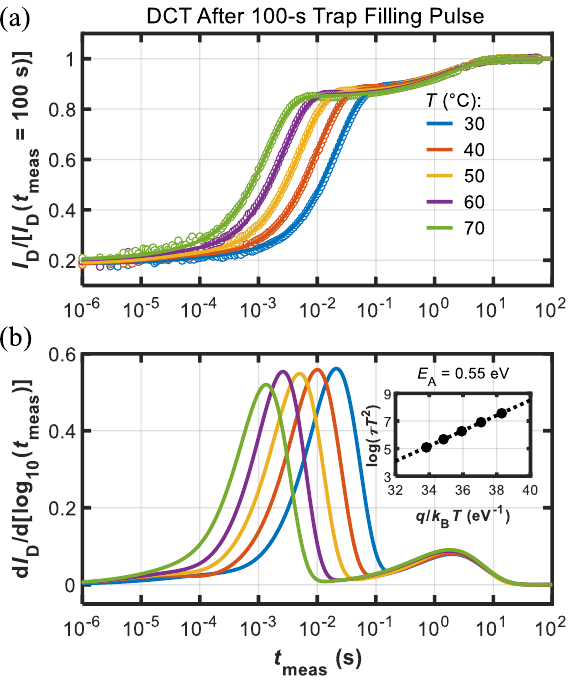
Figure 6. ( a ) DCTs measured at different temperatures (see legend) after the long 100 s trap-filling pulse (dots are data and lines are fitting functions). Current was normalized to final value, i.e., I D ( t meas = 100 s). ( b ) d I D /d[log10( t meas )] used for the extraction of the time constants ( τ ) to build the Arrhenius plot (see inset) that yielded E A = 0.55 eV. In this case, another T -independent process was